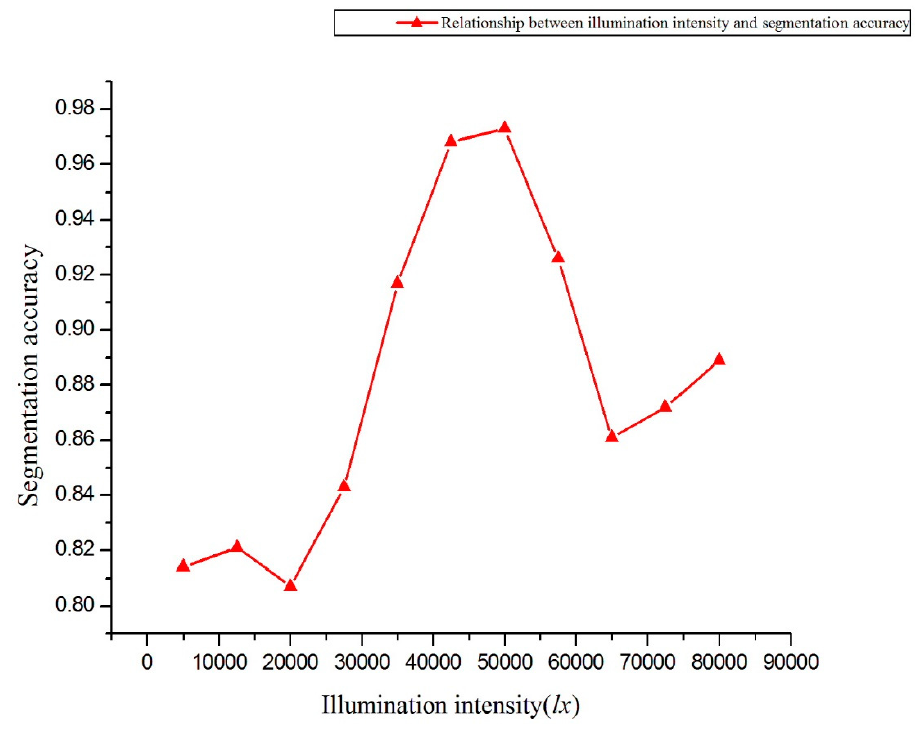
Figure 9. Segmentation accuracy as a function of illumination intensity.